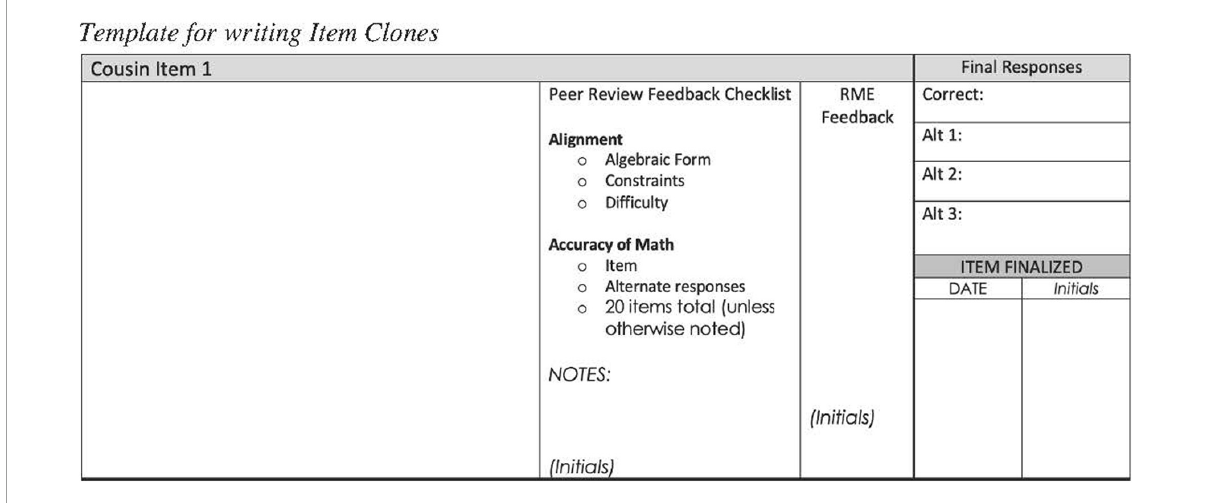
FIGURE7 Template for writing item